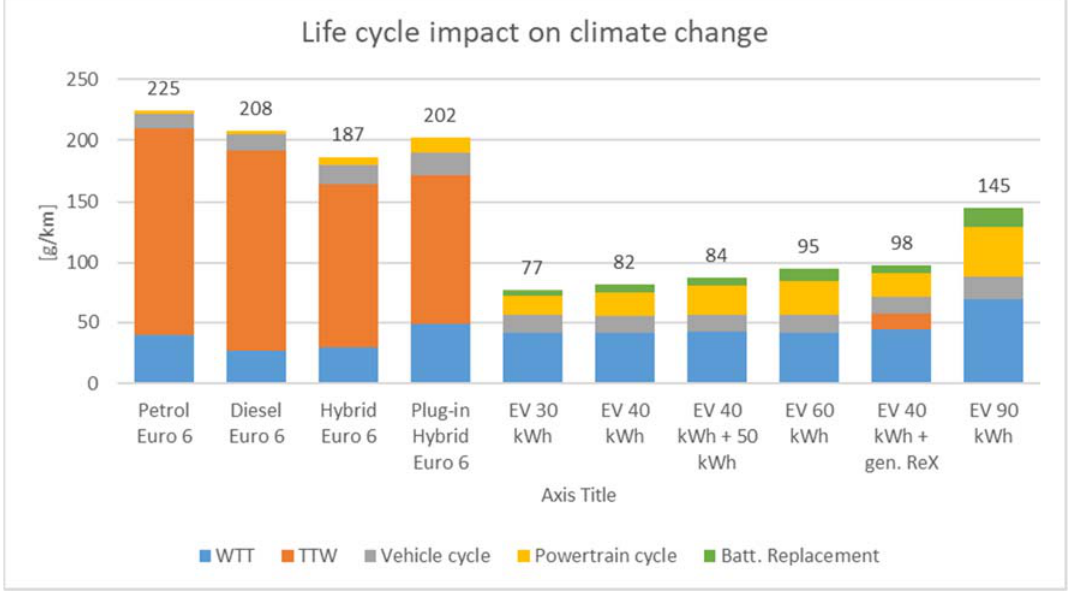
Figure 4. Impact per kilometer on climate change considering the entire LCA.